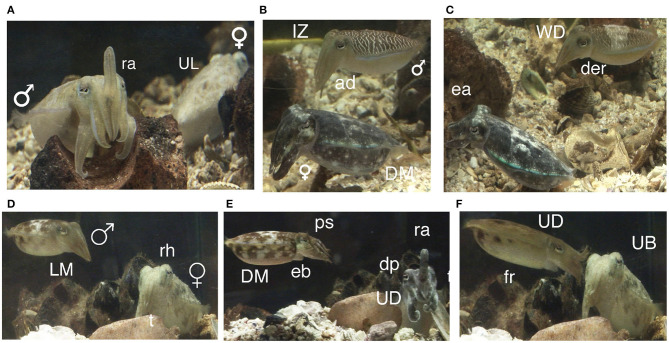
Signals and body patterns of Sepia plangon during courtship. The images were from the same pair during the same interaction. (A) Before courtship, a male with raised arms (ra) and female with uniform light pattern (UL). (B) Male began the courtship with Intense Zebra pattern (IZ) and arms dropped (ad), whereas female showed Dark Mottle pattern (DM). (C) Male transitioning to Weak Disruptive (WD) and dark eye ring (der). Female maintained rejection signal (Dark mottle) and extended arms (ea). (D) Male with light mottle (LM). Female in tripod posture (t) and raised head (rh). (E) Male with elongated Body (eb), DM, and papillate skin (ps). Female showed Uniform Darkening (UD), dilated pupils (dp) and ra. (F) Female switched to uniform blanching pattern (UB) while male with UD coloration rushed forwards (fr) to touch the female's head.